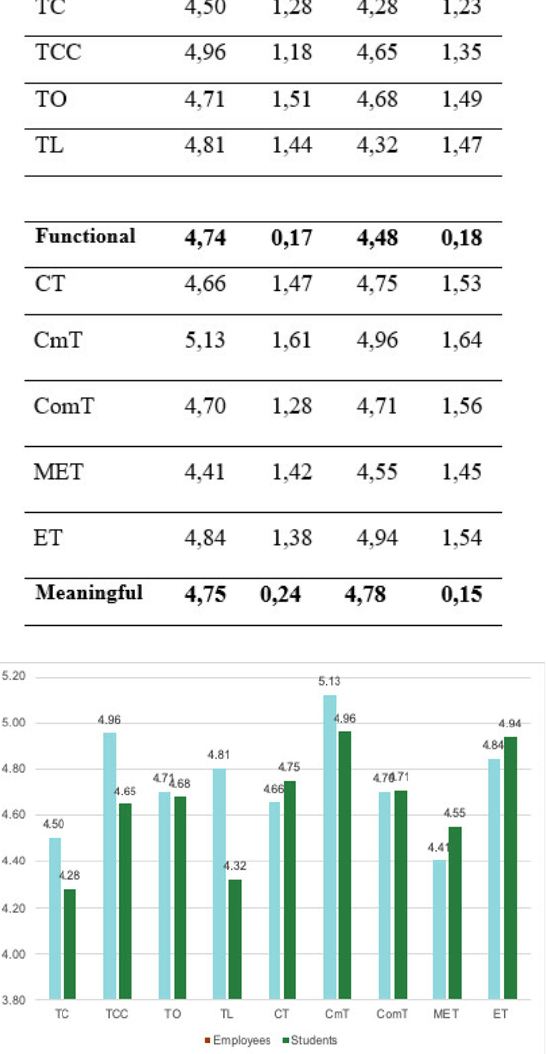
Figure 2. Comparison of social cohesion between all respondents and employees by